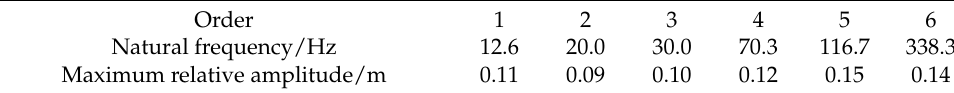
Table 4. The first six natural frequencies and amplitudes.